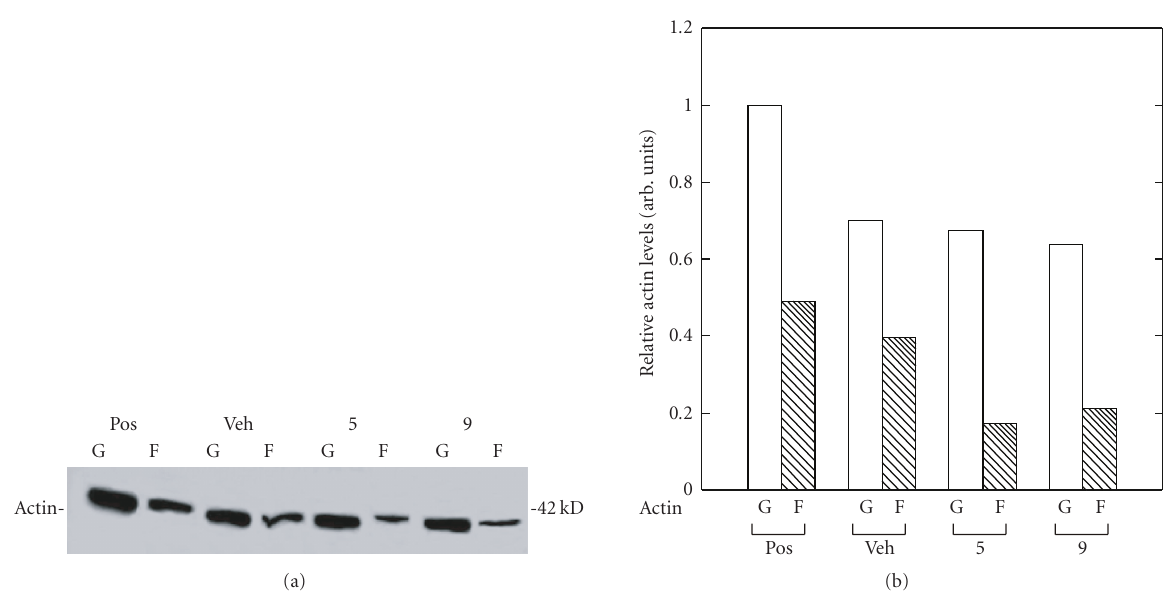
Figure 4: (a) Western blot for G- and F-actin levels in MDA-MB 435 breast cancer cells cultured on fibronectin for 4hours. Positive control (lanes 1 and 2) and ethanol control (lanes 3 and 4) were compared to cells in the presence of 36 ng/ μ L of compound 5 (lanes 5 and 6) and 36ng/ μ L of compound 9 (lanes 7 and 8) by probing with an antibody for G-actin. Odd numbered lanes represent G-actin while even numbered lanes represent F-actin totals. (b) Densitometry of the intensity of G- and F-actin bands.